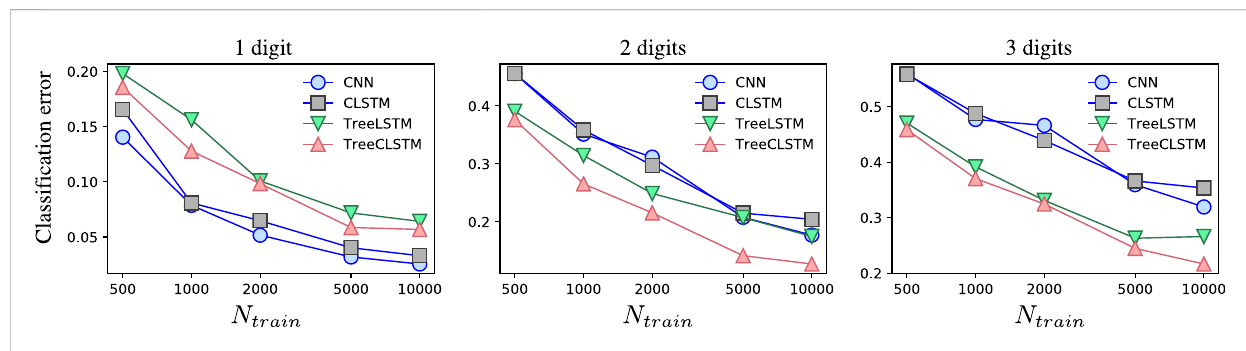
Model CNN (%) CLSTM (%) TreeLSTM (%) TreeCLSTM (%) Cls. Error The bold value indicates the best performance.